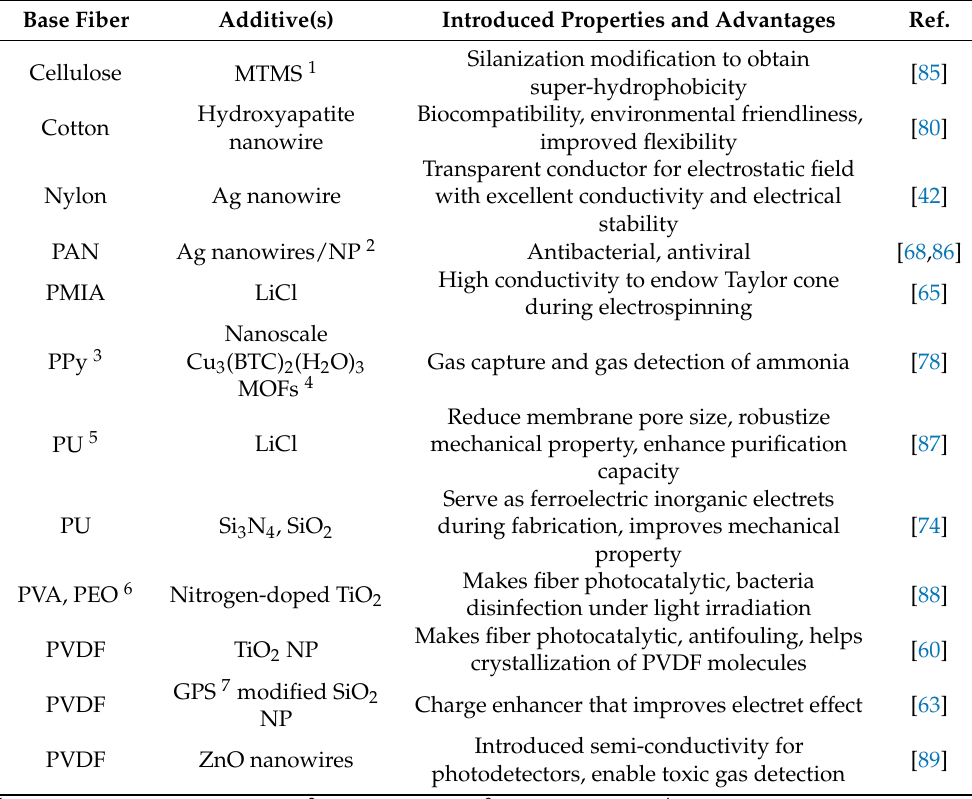
Table 1. Typical additives in nanofibers that introduce functionalities to the filter or enhance filtration